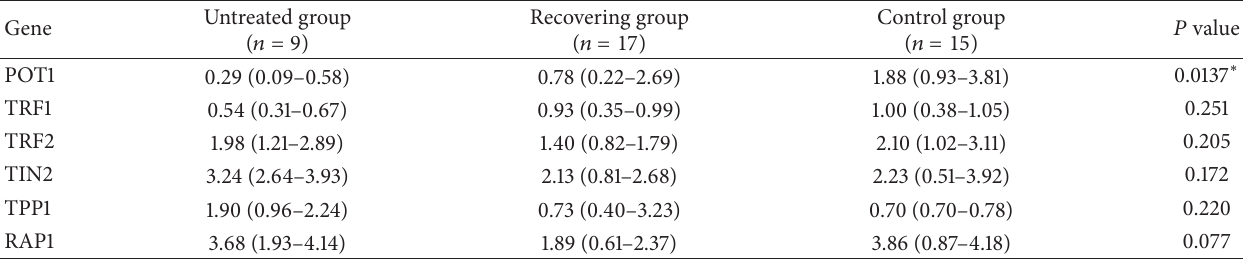
Table 3: Shelterin complex mRNA expression in PWBCs [𝑥 ± 𝑠 , M (𝑃 25 – 𝑃 75 )] .